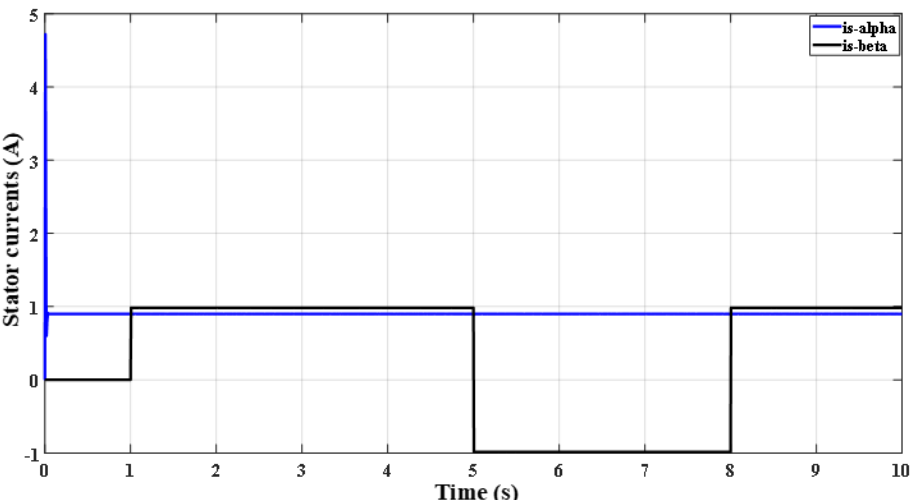
Figure 17. The testbed behaviour of the FOC algorithm for stator current vector components re- sponses.